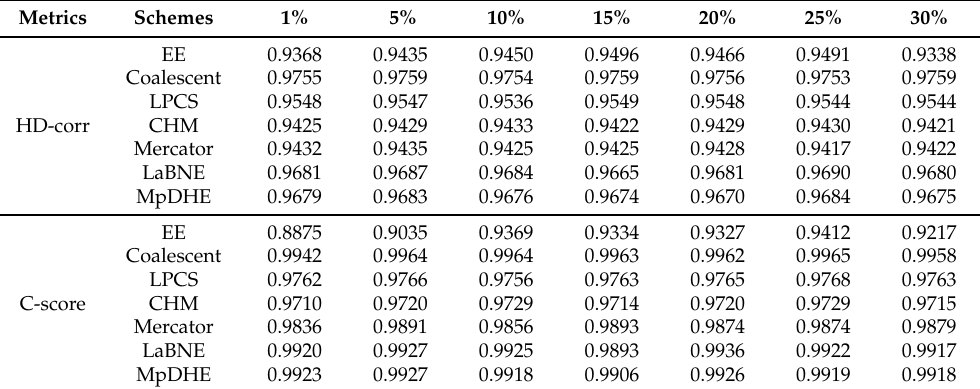
Table 1. The hyperbolic embedding performance for different proportions of changed nodes.